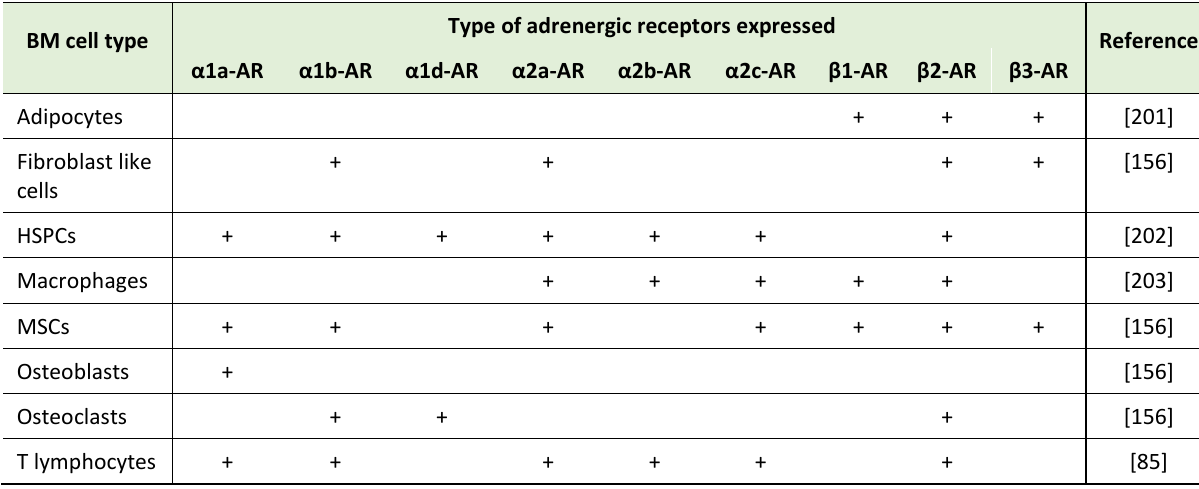
TABLE 1: Expression of ARs on the surface of different BM cell type in